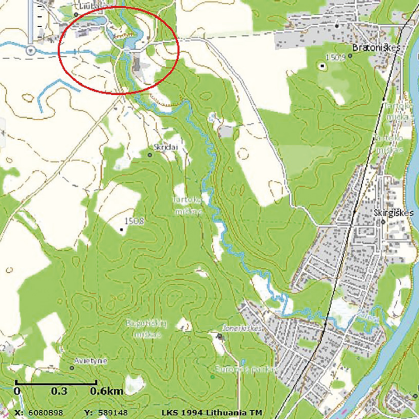
Figure 2: River ˇZalesa (the mill-museum in the red circle) (source: http://www.geoportal.lt).